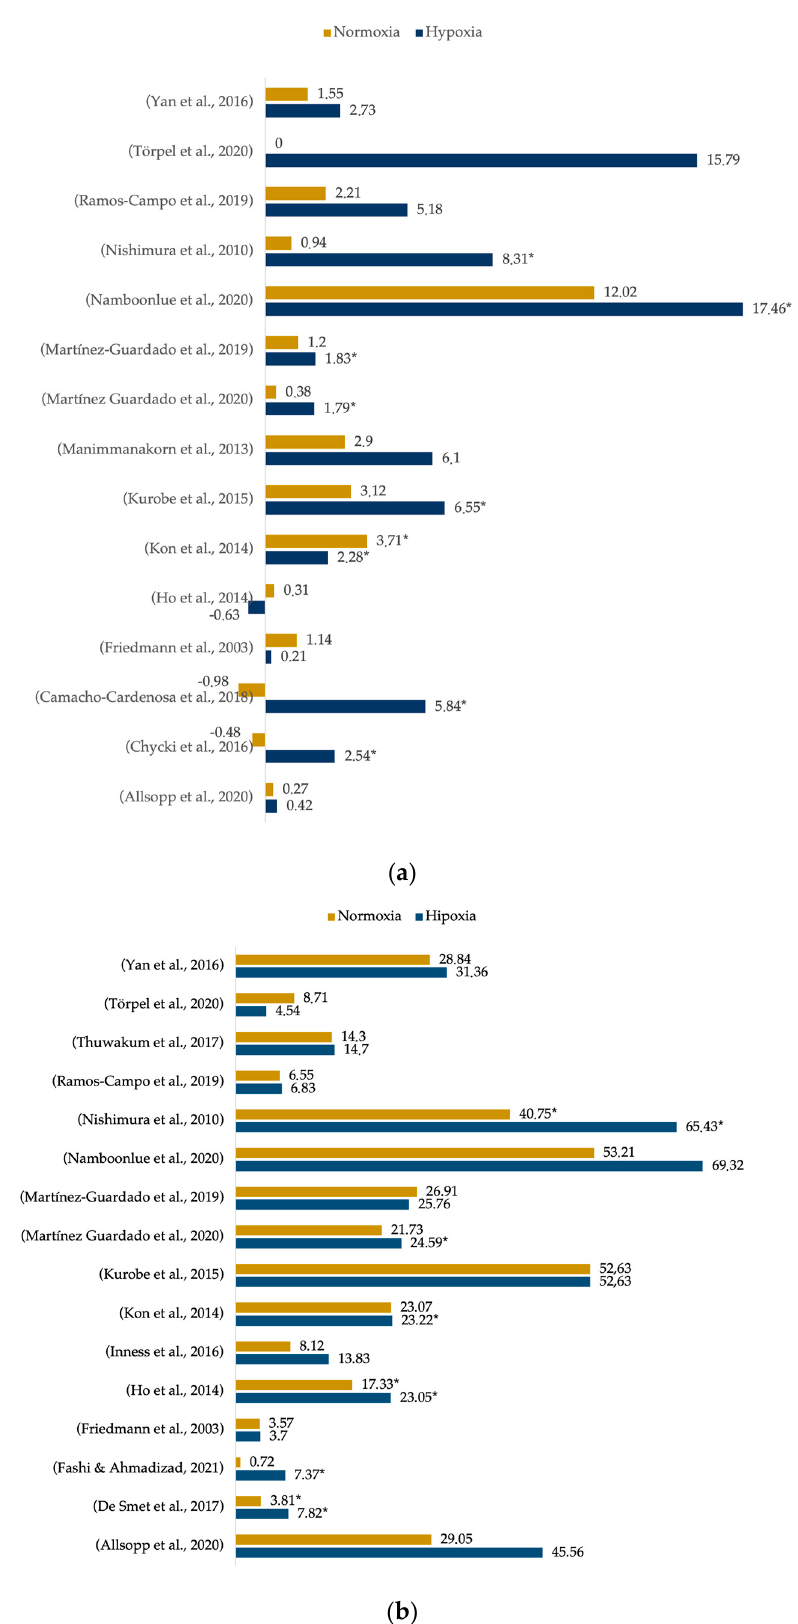
Figure 4. Percentages of change in hypertrophy ( a ) and strength ( b ) before and after training by group. * Significant difference.